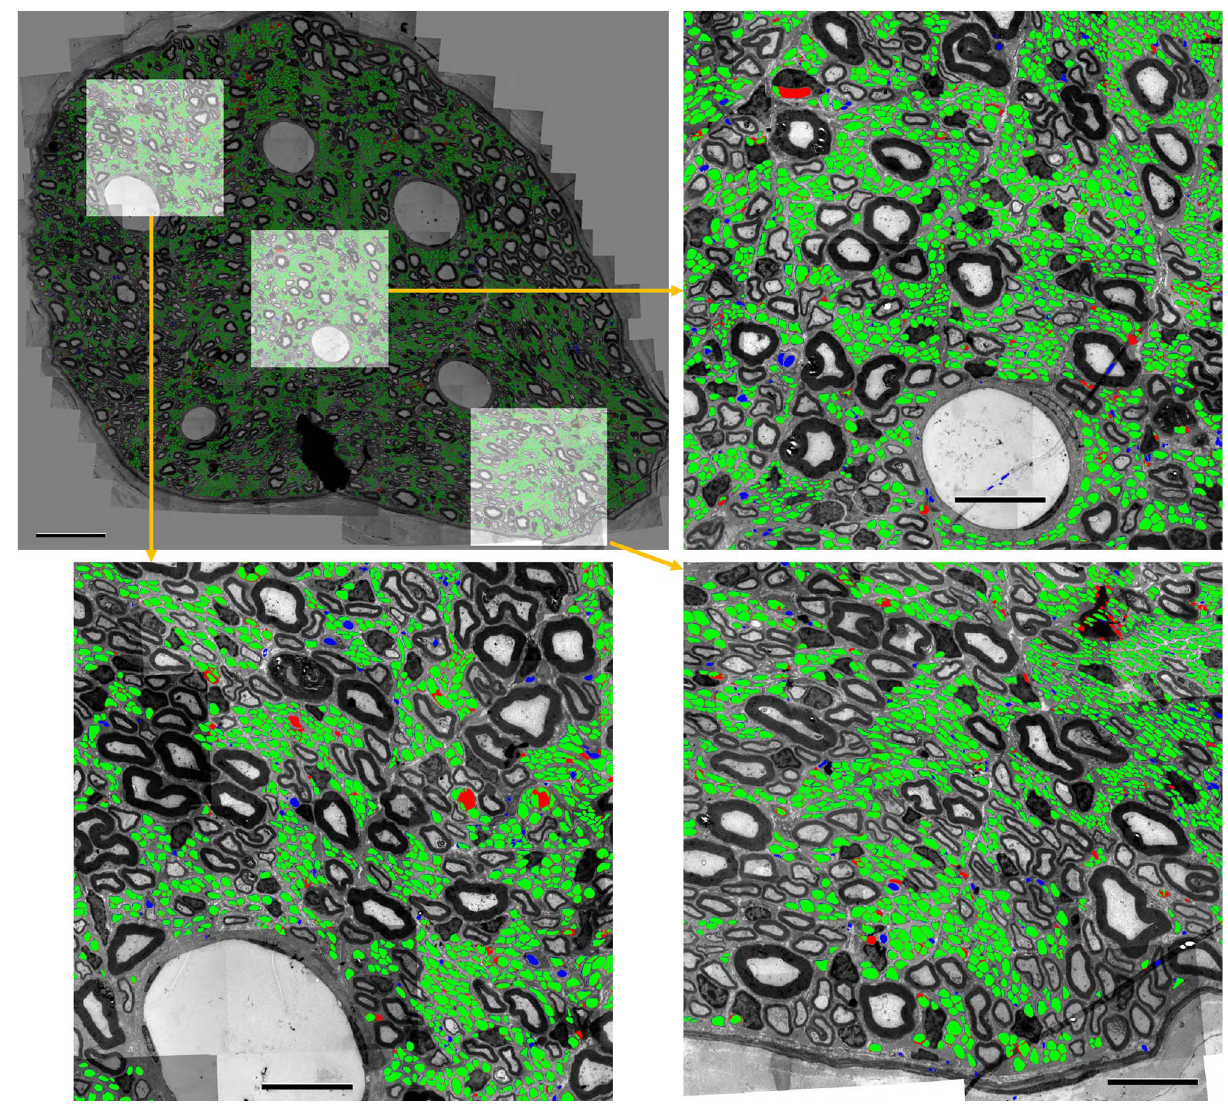
and 10 µ m otherwise. SQ = 0.872 and RQ = 0.909